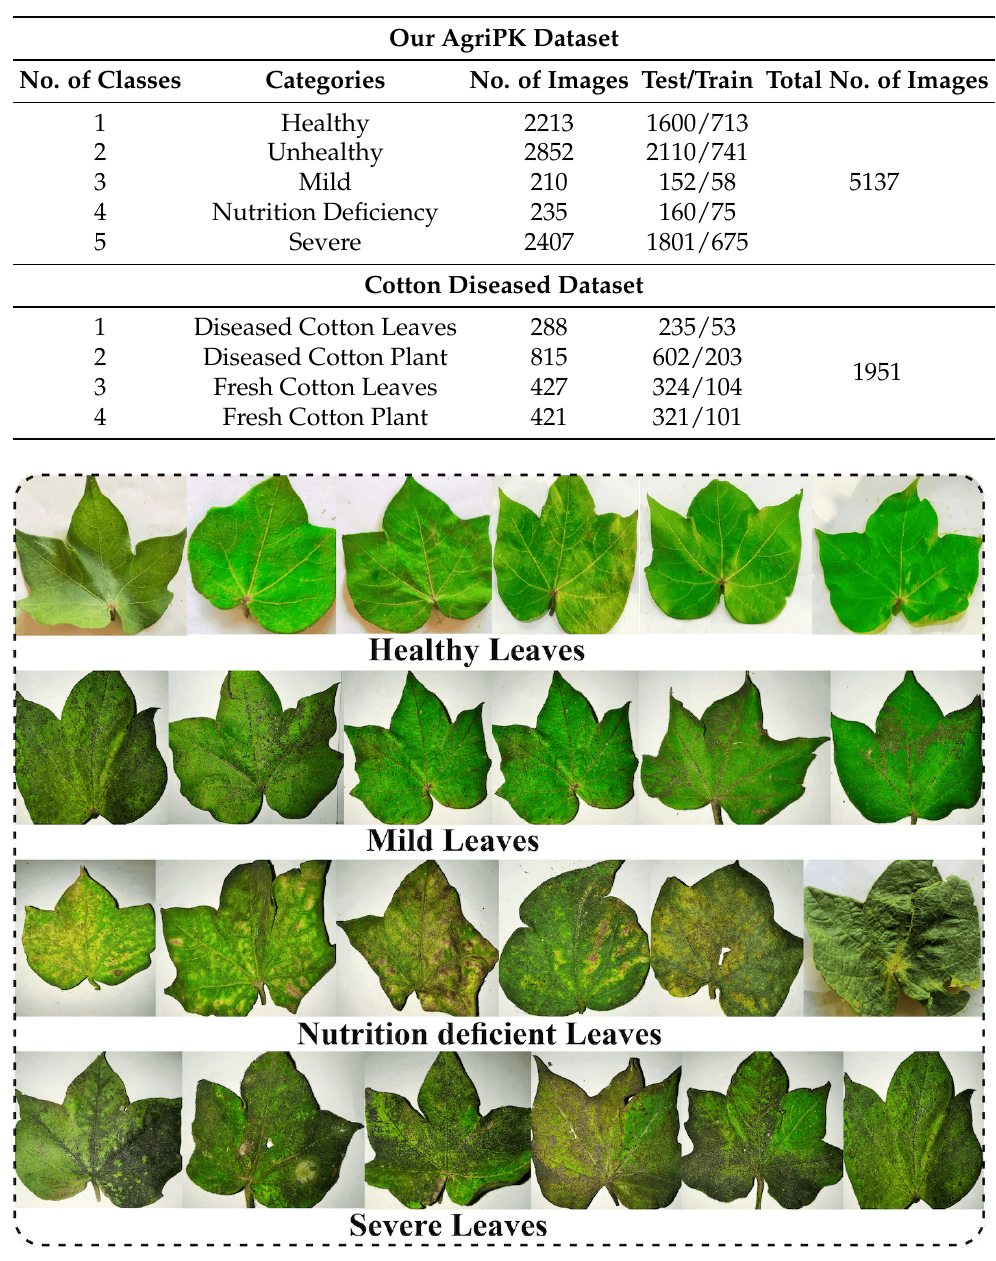
Figure 1. Our proposed AgriPK